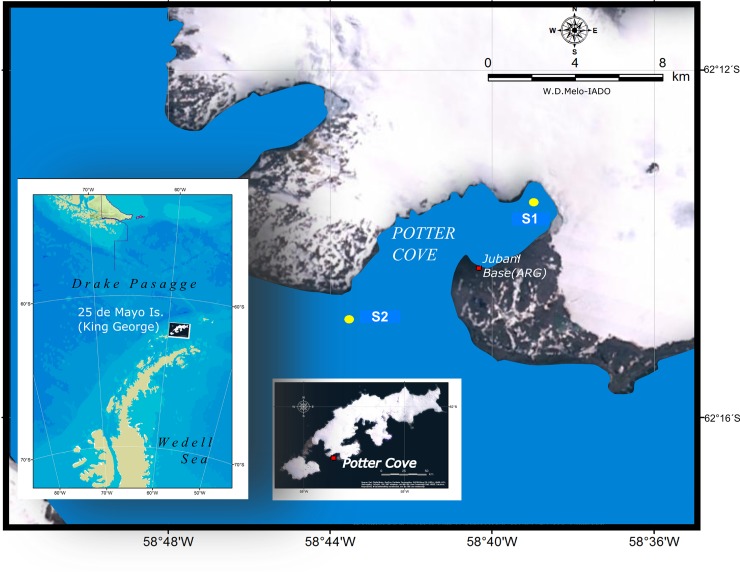
Study area (Potter Cove; Isla 25 de Mayo/King George Island).Location of the sampling sites: Site 1 (S1) was located at the inner zone close to the base of Fourcade Glacier, whereas Site 2 (S2) was located at the outer zone close to Maxwell Bay. Images are LANDSAT 8 OLI / TIRS, obtained from the US Geological Survey (https://earthexplorer.usgs.gov) and using ArcGis 10.1 software.